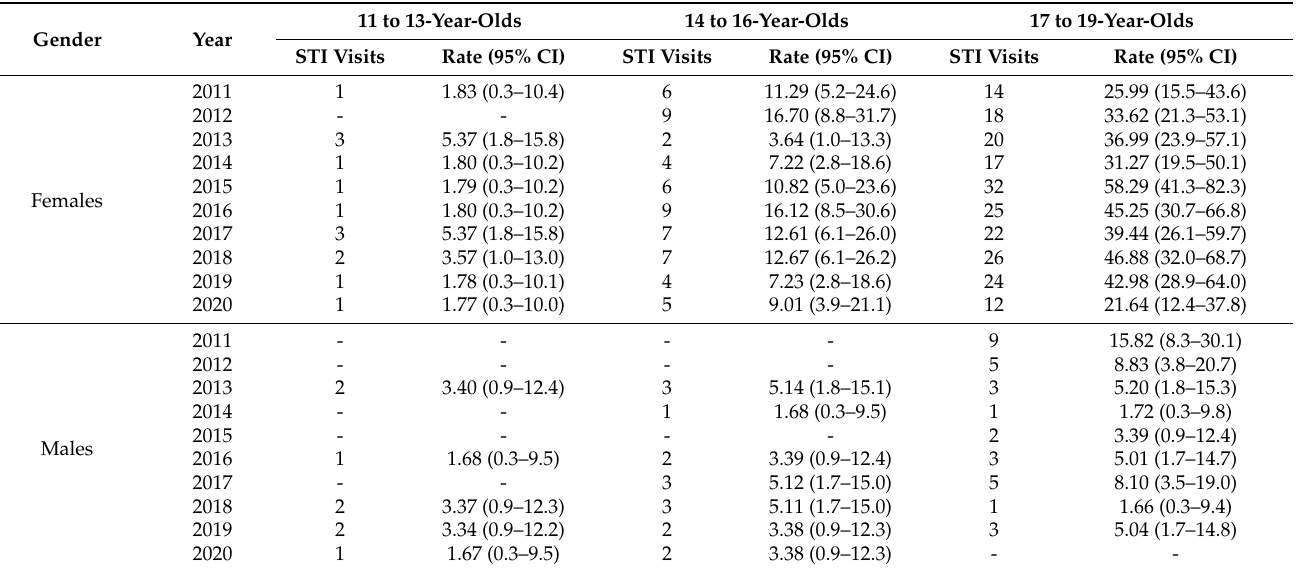
males in the 11 to 13 and in 14 to 16 years old group than in girls of the same age, while it was almost equal in the oldest group. Table 1. Emergency department (ED) visits, absolute frequency, age-specific rate per 100,000 inhabi- tants for sexually transmitted infection (STIs), in 11 to 13, 14 to 16 and 17 to 19-year-old adolescents, by gender, years 2011 to 2020, Piedmont region, Italy.